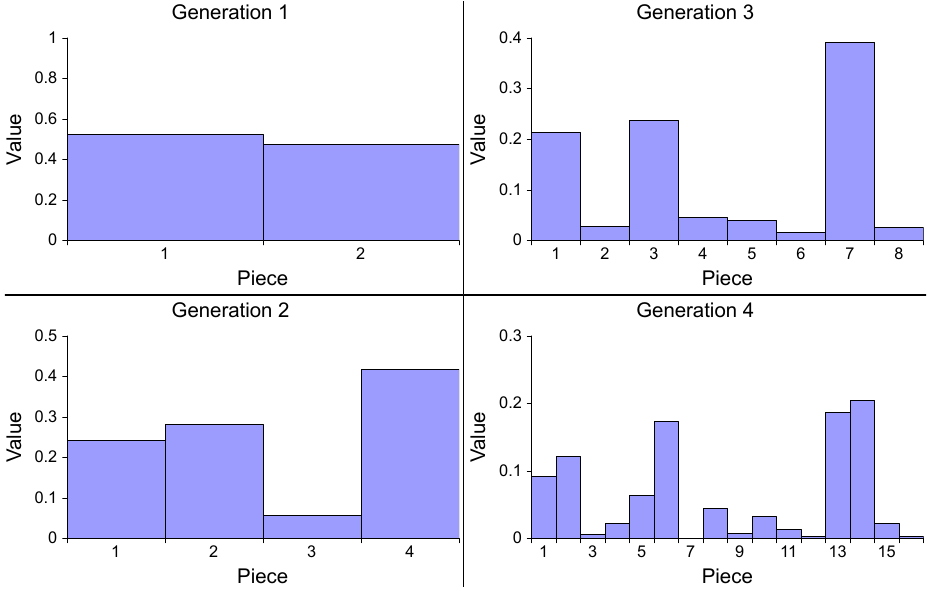
Fig. 7. Schematic illustration of four generations of the multiplicative cascade method. In each generation, the total value of all pieces is 1.